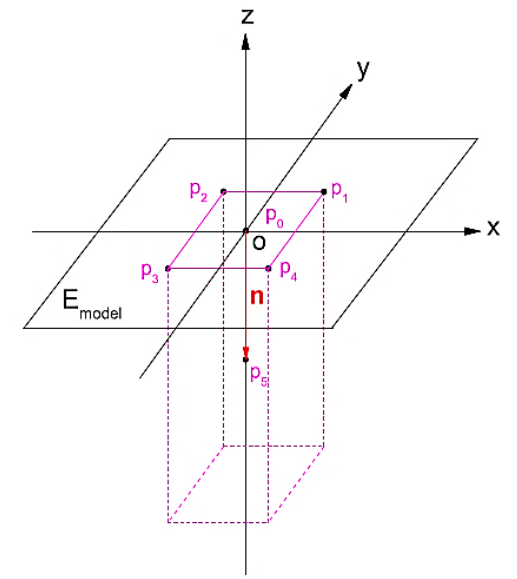
Figure 4. Rectangular microstructure calculation theory construction pattern.